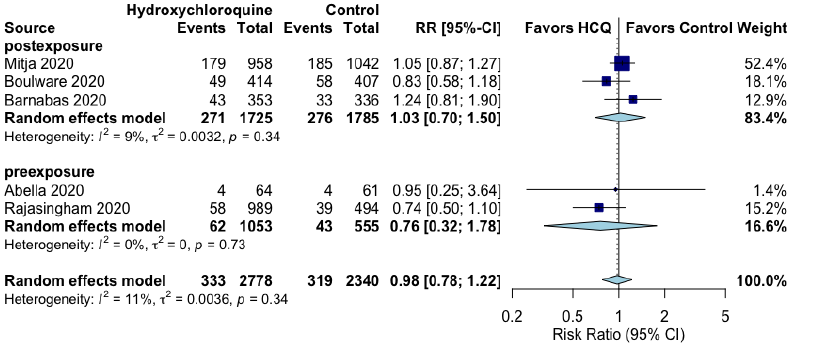
Figure 1. Effect of prophylaxis with hydroxychloroquine on RT-PCR-confirmed SARS-CoV-2 positivity.